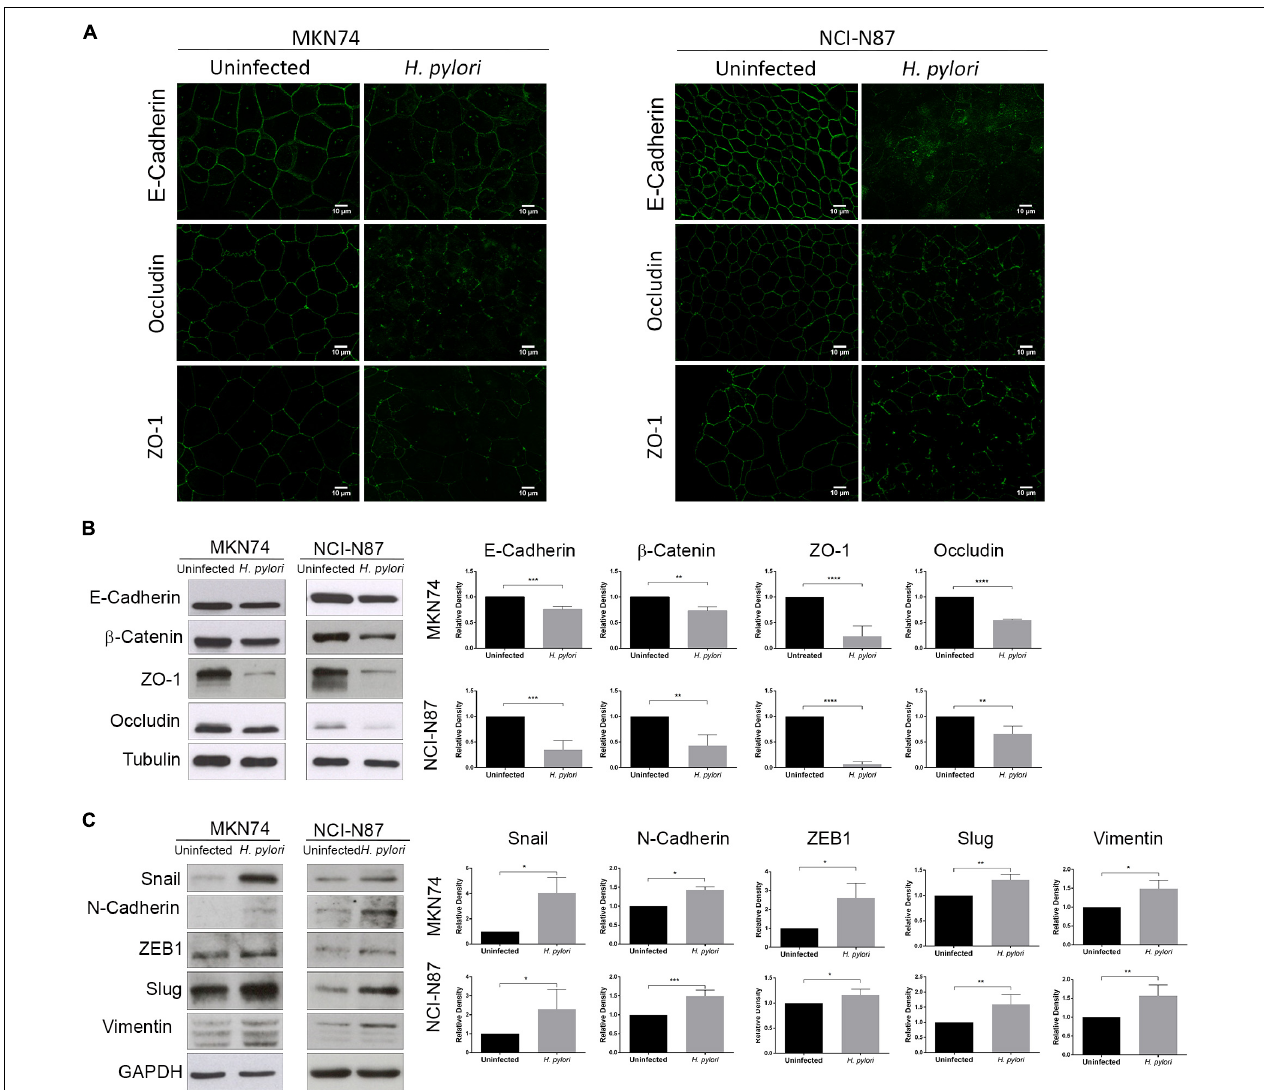
FIGURE 2 | H. pylori induces an EMT phenotype in epithelial gastric cells. MKN74 and NCI-N87 gastric cell lines were left untreated or infected with H. pylori 26695 for a period of 24 h at a MOI of 100. (A) Immunofluorescence of E-cadherin, occludin, and ZO-1. Scale bar, 10 µ m. (B) Western blot and respective quantifications of the levels of apical junctional complex proteins E-cadherin, β -catenin, ZO-1, and occludin. Tubulin was used as loading control. (C) Western blot and respective quantifications of the levels of mesenchymal markers Snail, N-cadherin, ZEB1, Slug, and Vimentin. GAPDH was used as loading control. Data correspond to the mean value ± SEM and are representative of three independent experiments. Statistical significance was evaluated with the Student’s t- test.